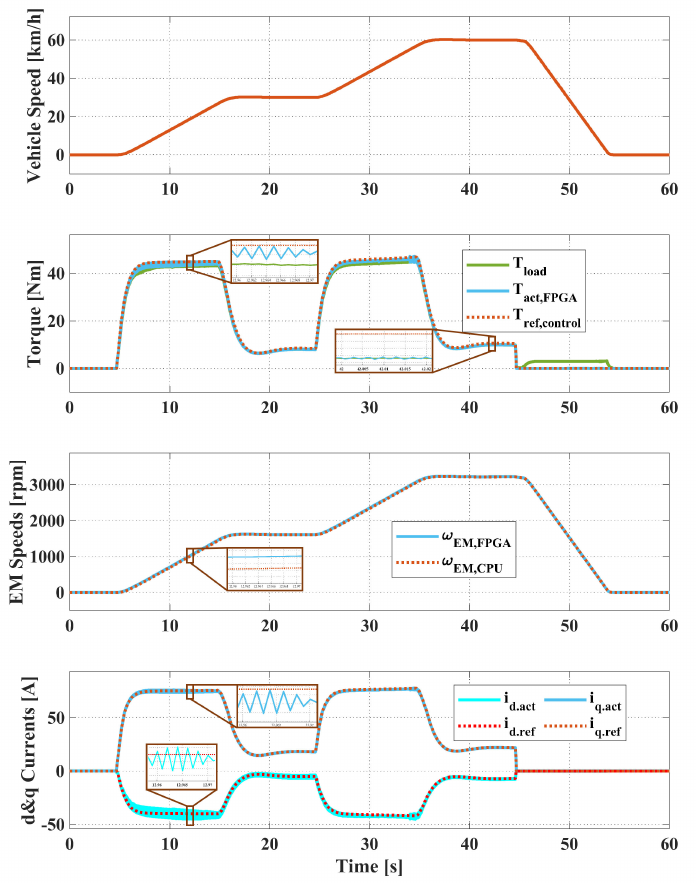
Figure 8. Torque closed-loop real-time simulation